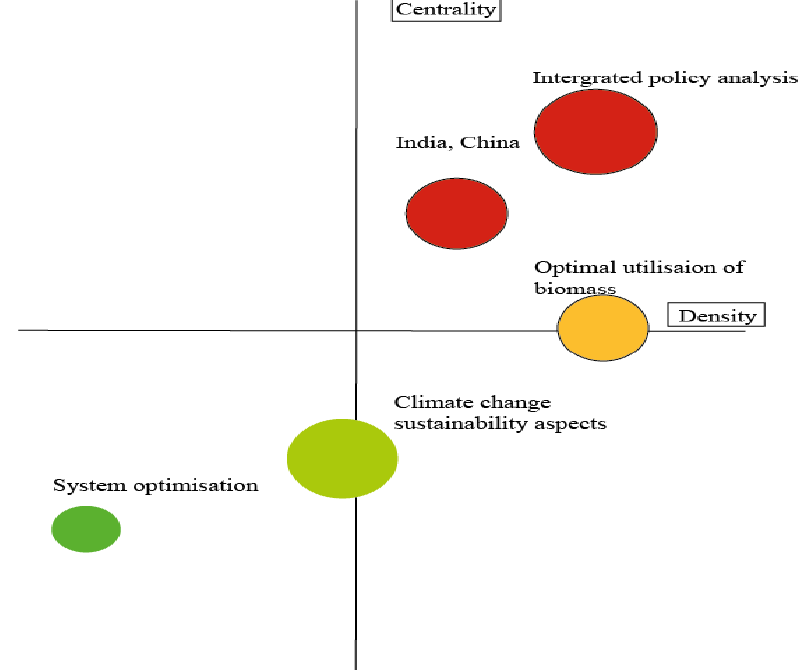
Figure 1. Results of the thematic bibliometric mapping of publications dealing with the socio-economic aspects of bioenergy (1994–2000; 2001–2008; 2009–2020).